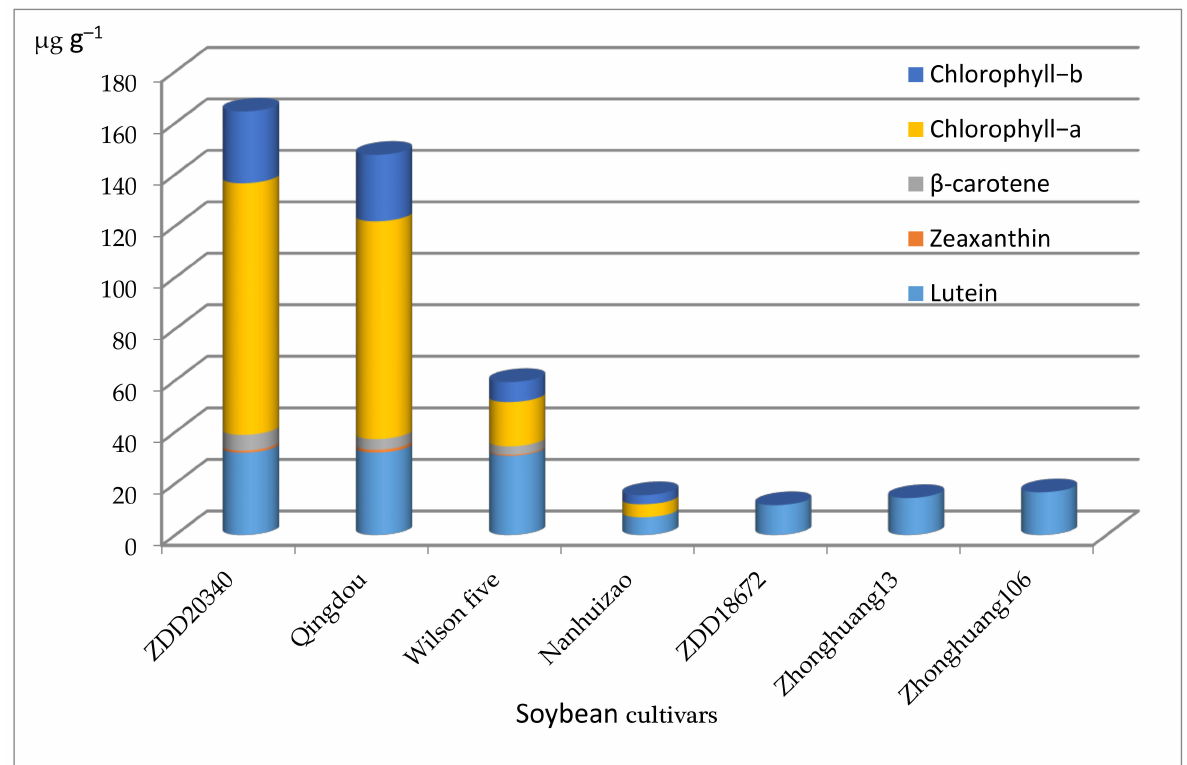
Figure 3. Carotenoid and chlorophyll compositions and contents in soybean cultivars with different seed coat colors. Soybean cv. ZDD20340, Qingdou and Wilson five (green seed coat color); Nanhuizao (black seed coat color); ZDD18672, Zhonghuang13 and Zhonghuang 106 (yellow seed coat